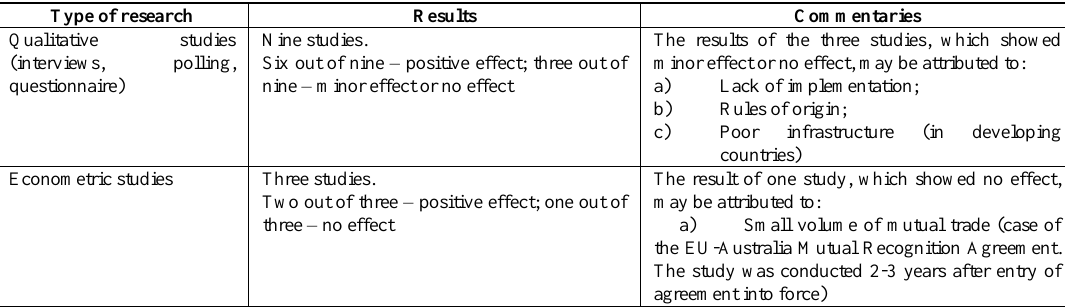
Table 2. Research results of Mutual Recognition Agreements effect on trade (Correia de Brito et al., 2016) Type of research Results Commentaries Qualitative studies Nine studies. (interviews, polling, Six out of nine – positive effect; three out of questionnaire) nine – minor effect or no effect